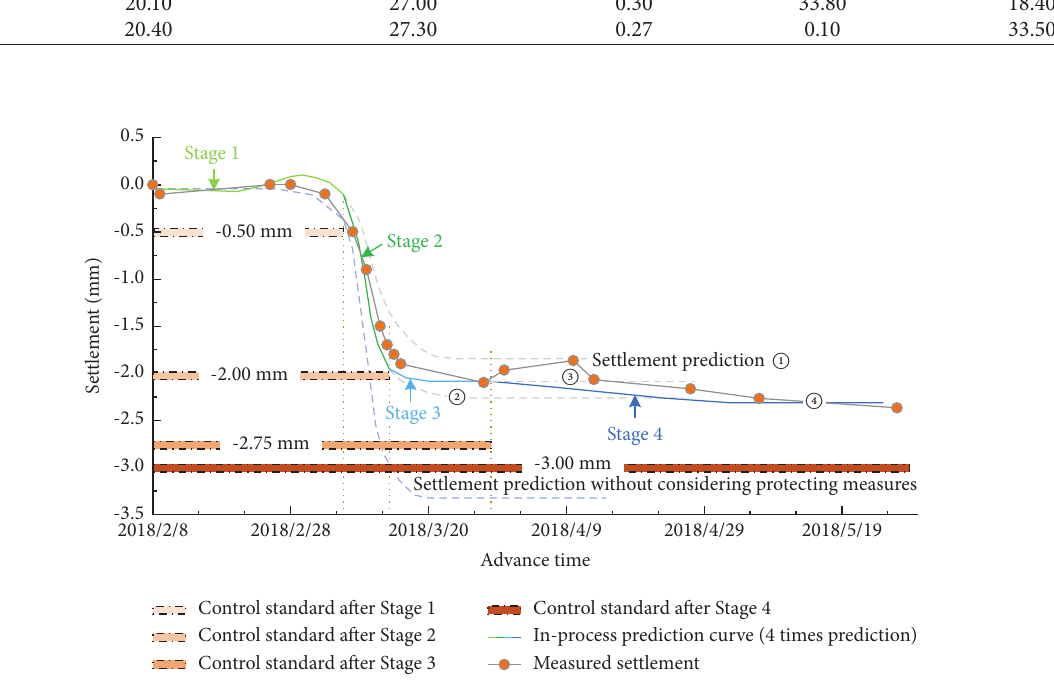
Figure 12: In-process control of tunnelling-induced